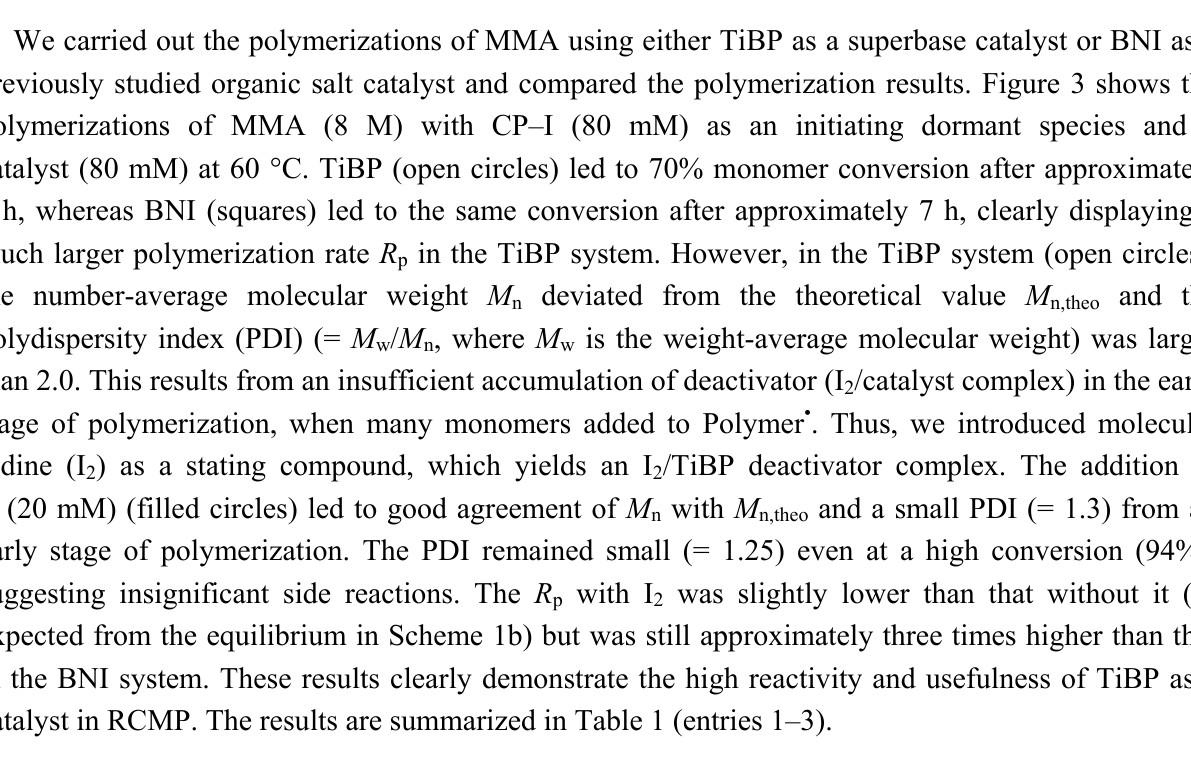
Figure 2. 1 H NMR spectra (in the range of 0.8–2.8 ppm) of the solution of CP–I (5 mM), TMG (80 mM) and TEMPO (80 mM) in toluene- d